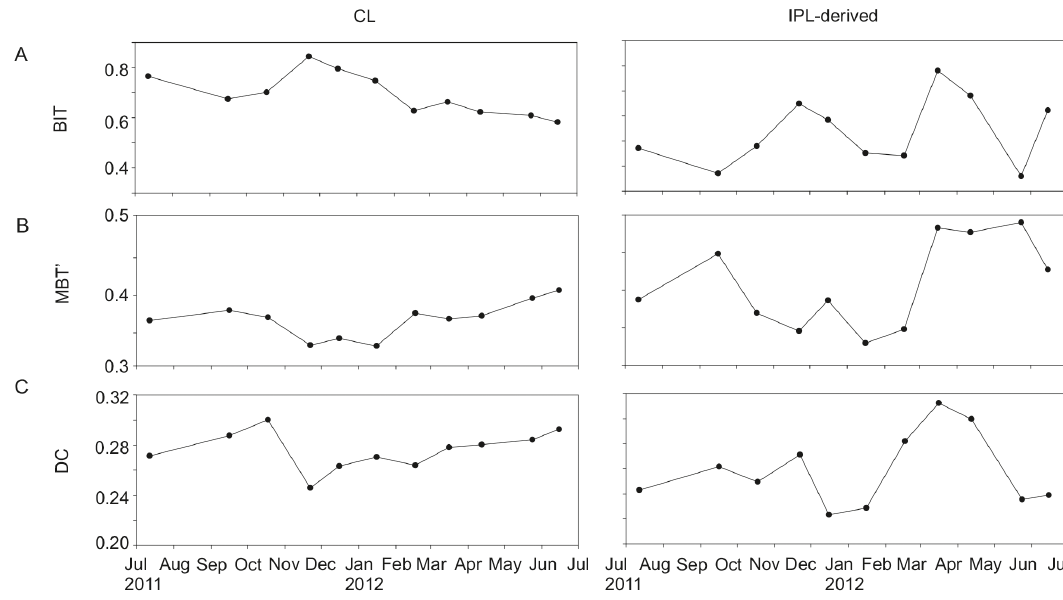
Figure 7. Variations in CL and IPL-derived BIT, MBT’, and DC in Tagus SPM over a year (2011–2012).